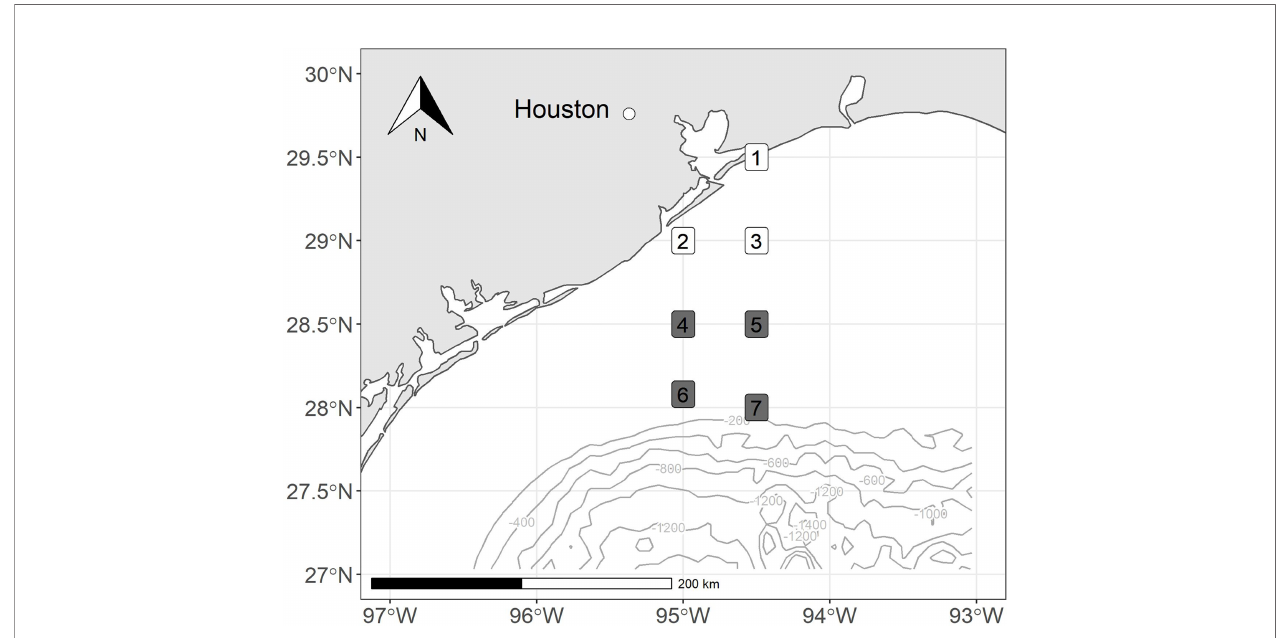
FIGURE 1 | Map of stations sampled off the coast of Texas, United States. Colors correspond to depth bin (nearshore = white, shelf = gray).